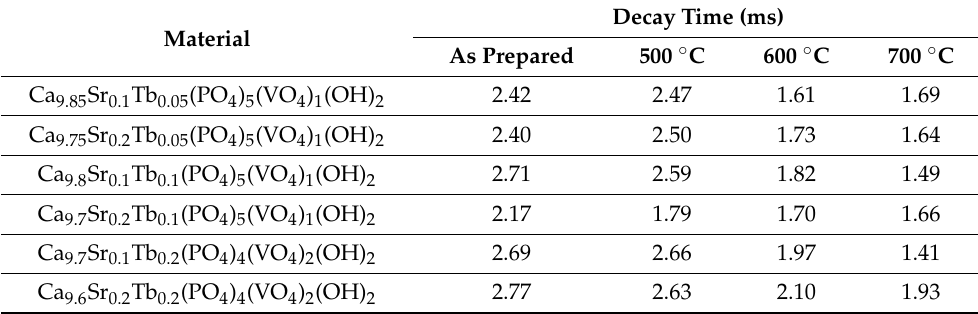
Table 3. The average fluorescence decay time for obtained materials measured in milliseconds. Decay Time (ms) Material